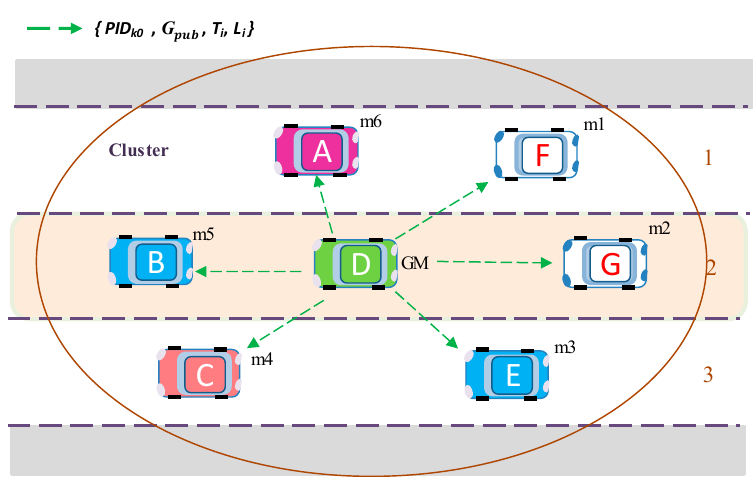
Figure 7. The GM broadcasting group public key G pub for group.